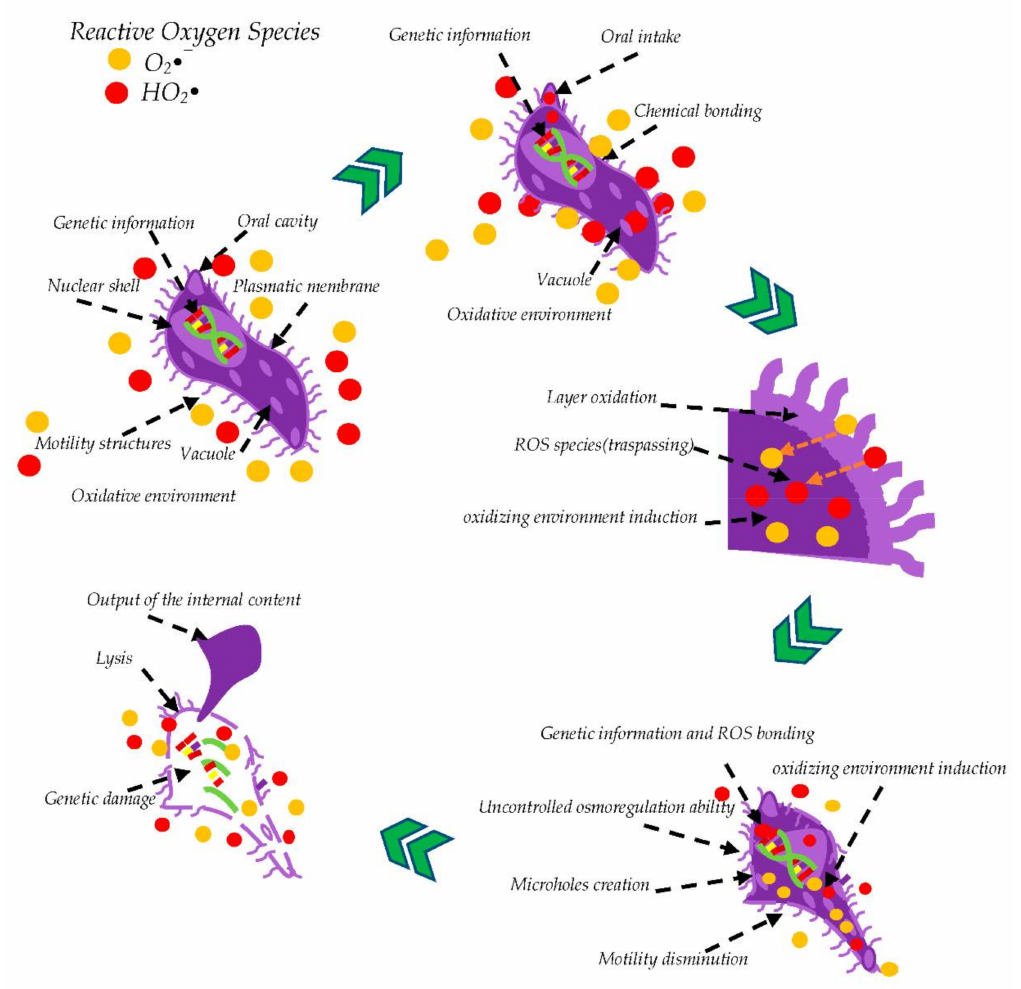
Figure 4. Disinfection mechanism purposed for Protozoa using TiO 2